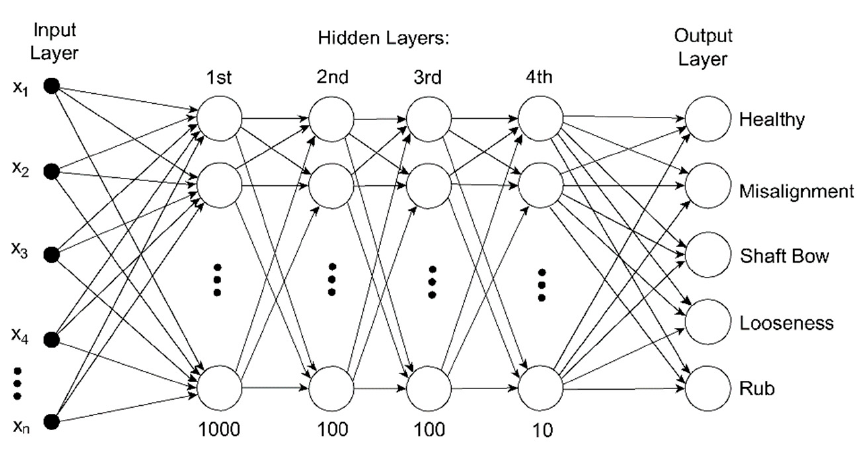
Figure 4. Multilayer perceptron neural network.